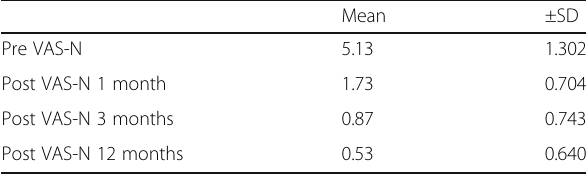
Table 2 Comparison between preoperative VAS-N and at different follow-up intervals among ACDF group